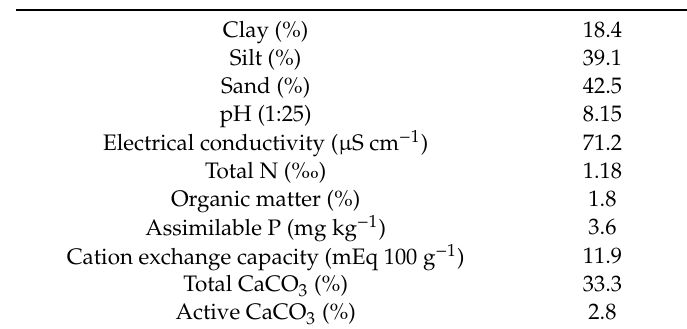
Table 4. Physical and chemical characteristics (0–30 cm depth) of the soil at the beginning of the field